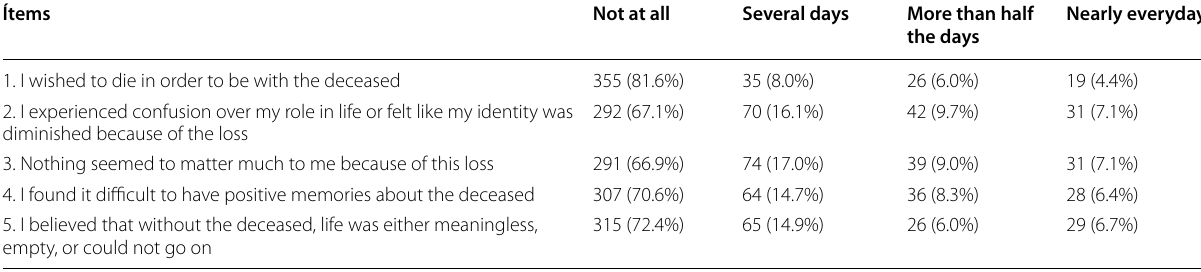
Table 2 Descriptive analysis of the Pandemic Grief Scale items